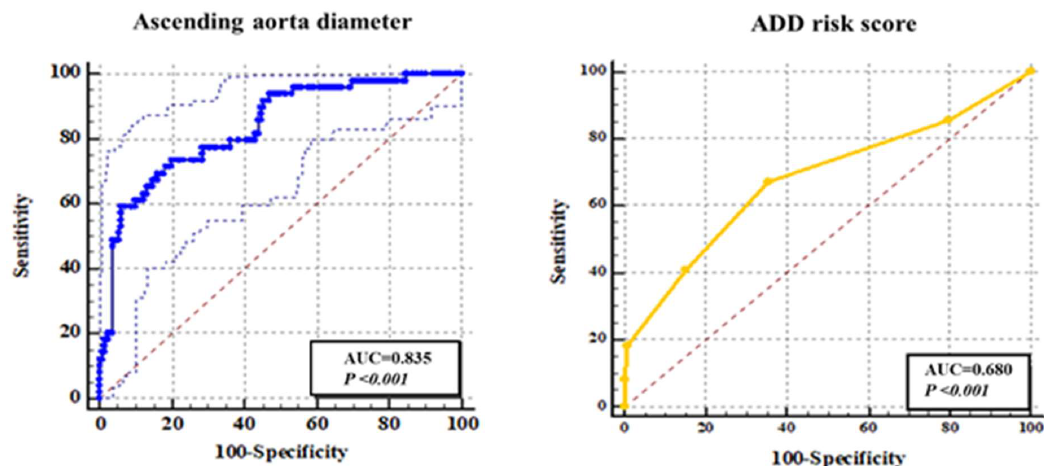
Figure 3. ROC curve showing the diagnostic performance of ADD score and ascending aorta diameter for A-AAS.